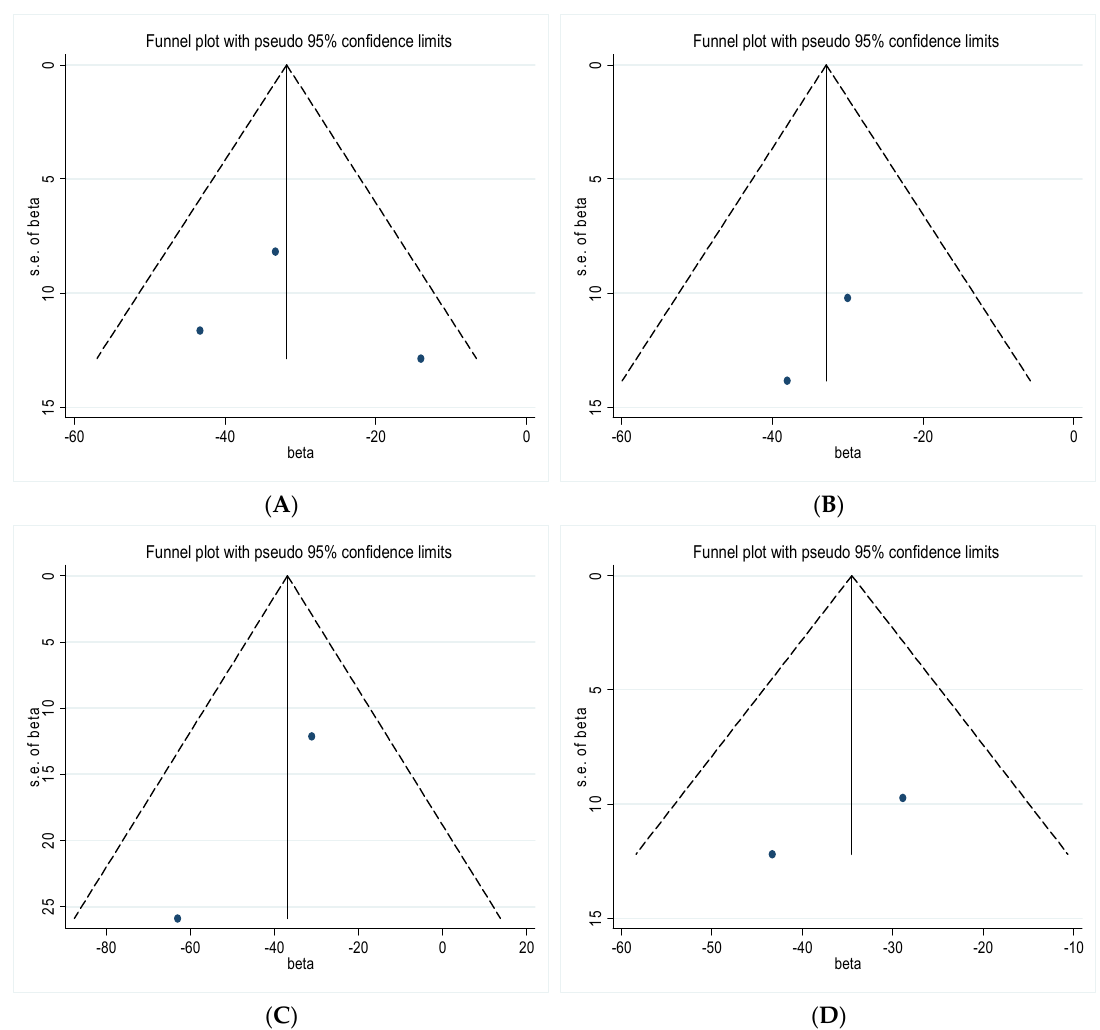
Figure 4. Funnel plot of the effects of PM 1 on lung function indicators in the short-term exposure group: ( A ) FVC, ( B ) FEV 1 , ( C ) PEF, ( D ) MMEF.